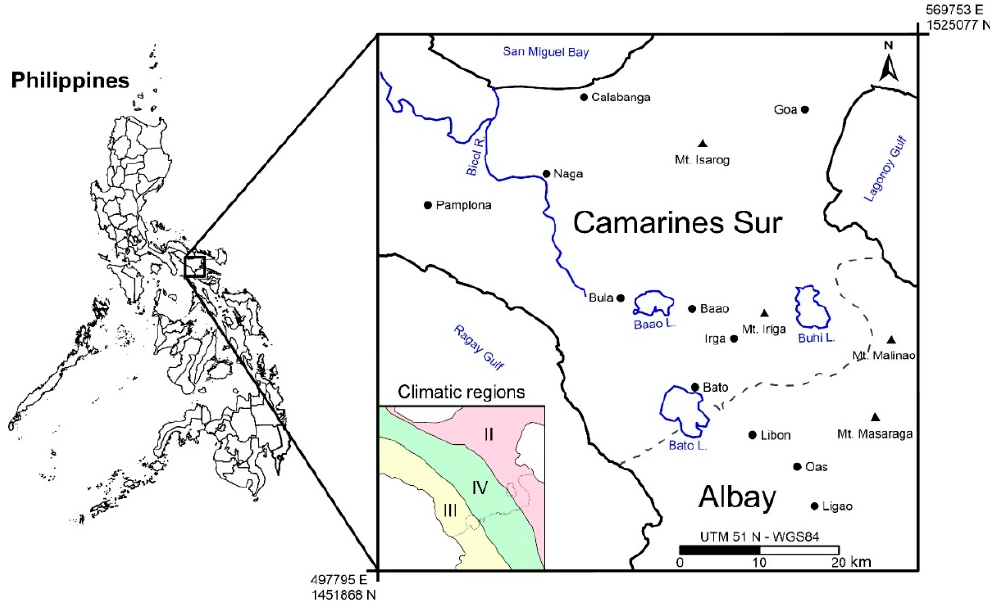
Figure 1. Map showing the study area (dashed line divides Camarines Sur and Albay provinces). The blue line indicates the major river, lakes are represented by blue polygons, towns are reported using black dots, and major reliefs are depicted by black triangles. The inset map shows the climatic regions of the study area.